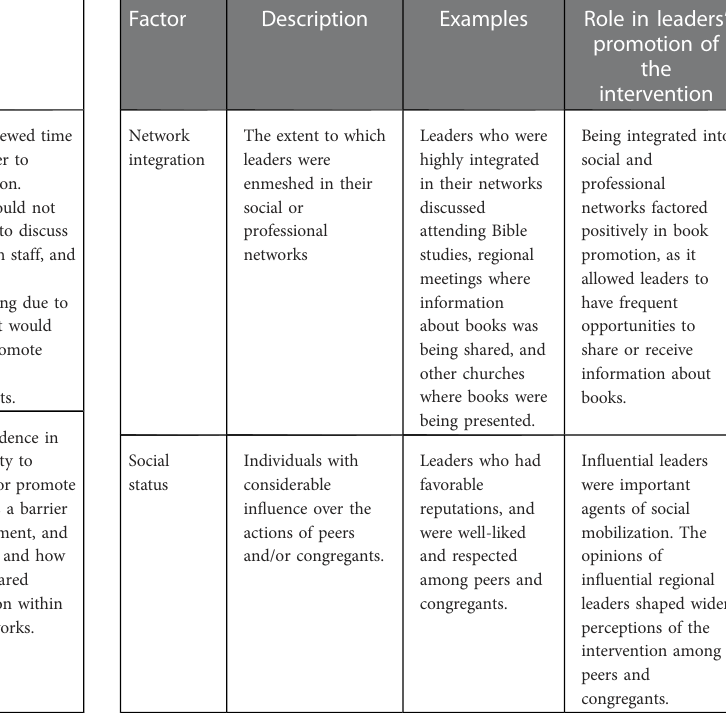
TABLE 2 The impact of interpersonal-level factors on church leaders ’ promotion of puberty